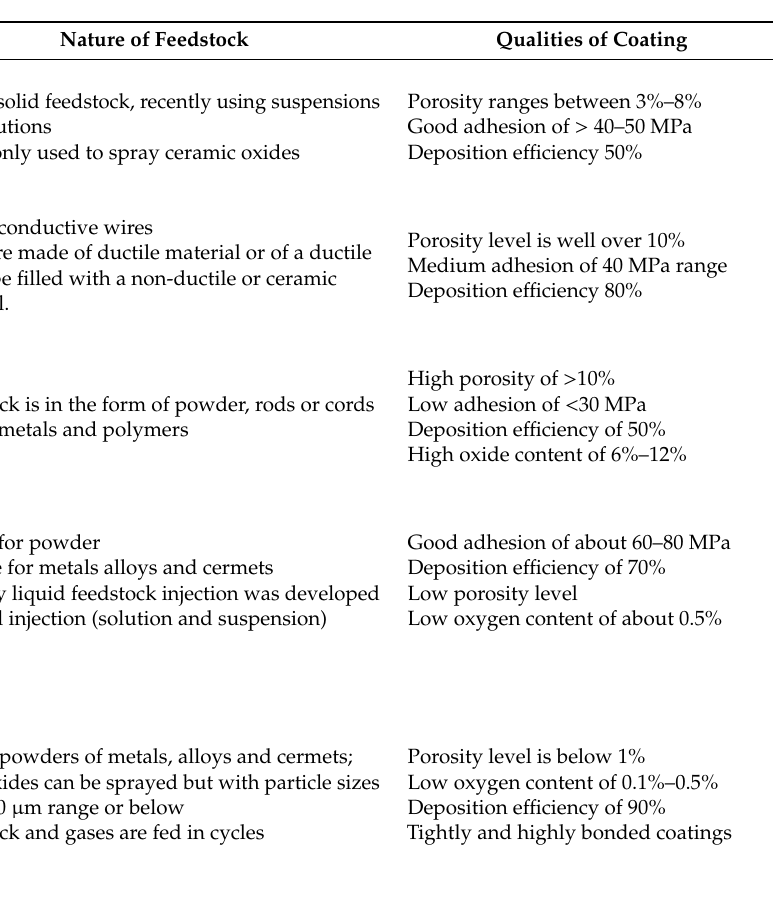
Table 1. Summary of thermal spray methods and nature of feedstock